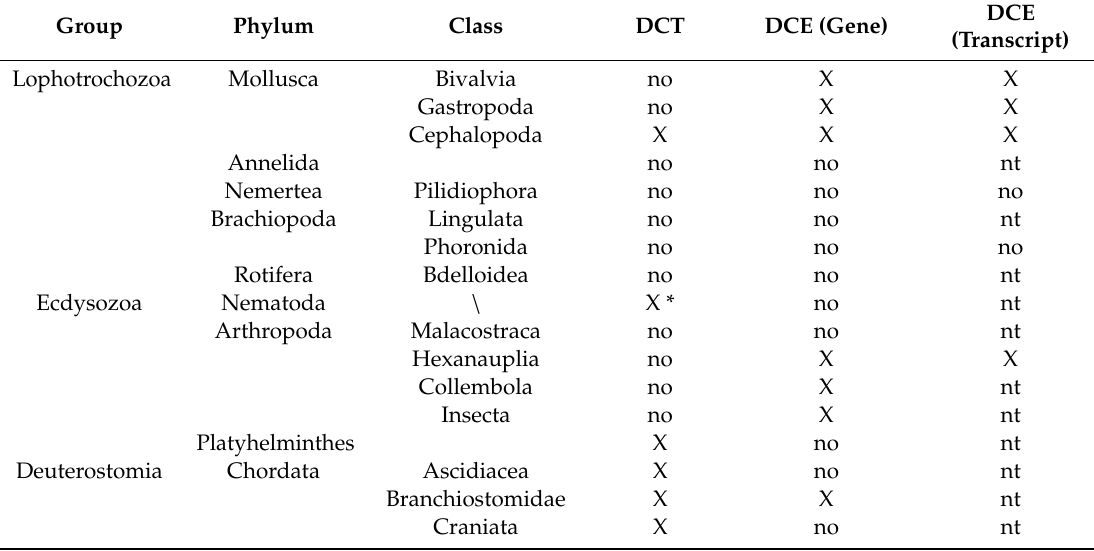
Table 1. Taxonomic distribution of DCT and DCE / yellow genes in Metazoa. Group, phylum, class, number of DCT and DCE / yellow genes per representative species are